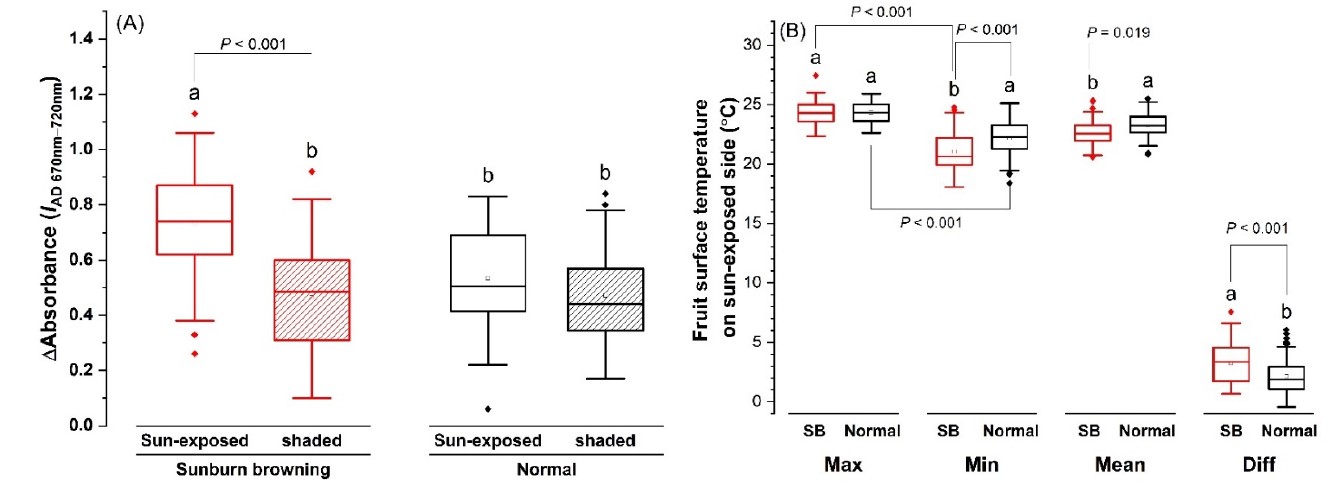
Figure 4. Fruit skin spectral characteristics of normal and sunburn browning (SB) ‘Ambrosia’ apple measured prior to harvest in 2021: ( A ) delta absorbance I AD 670–720 nm of sun-exposed and shaded sides measured two weeks prior to harvest; ( B ) maximum (T max ), minimum (T min ), mean (T mean ), and differential (T diff ) skin surface temperatures of sun-exposed side measured in late August. Different letters a and b in each pair of SB-normal comparisons stand for statistical significance at p ≤ 0.05 (ANOVA); statistical significance between T max and T min of the same fruit type was shown in brackets (ANOVA, Tukey pairwise comparison).